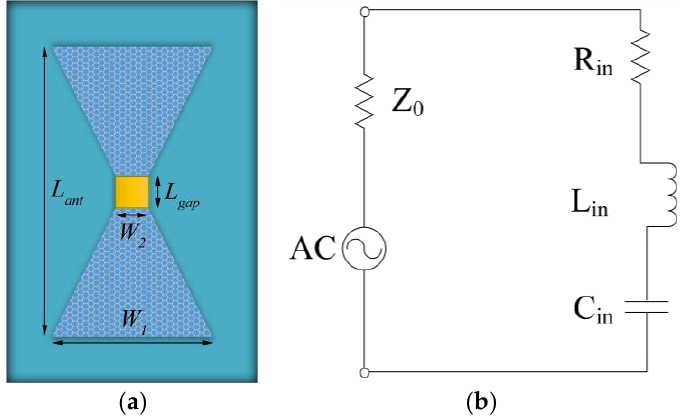
Figure 1. ( a ) The schematic of the graphene-based bowtie antenna; ( b ) the corresponding equivalent resonant circuit.